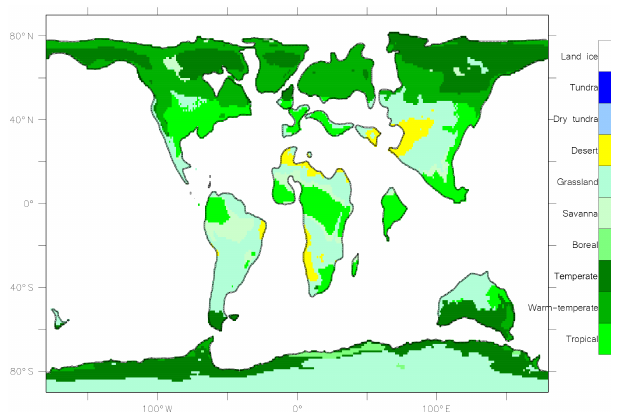
Figure 4. Vegetation, expressed as megabiomes, for the palaeocli- mate simulations in DeepMIP. A netcdf file of the data at a 1 ◦ × 1 ◦ resolution is available in the Supplement of Herold et al. (2014) (see Table 2).